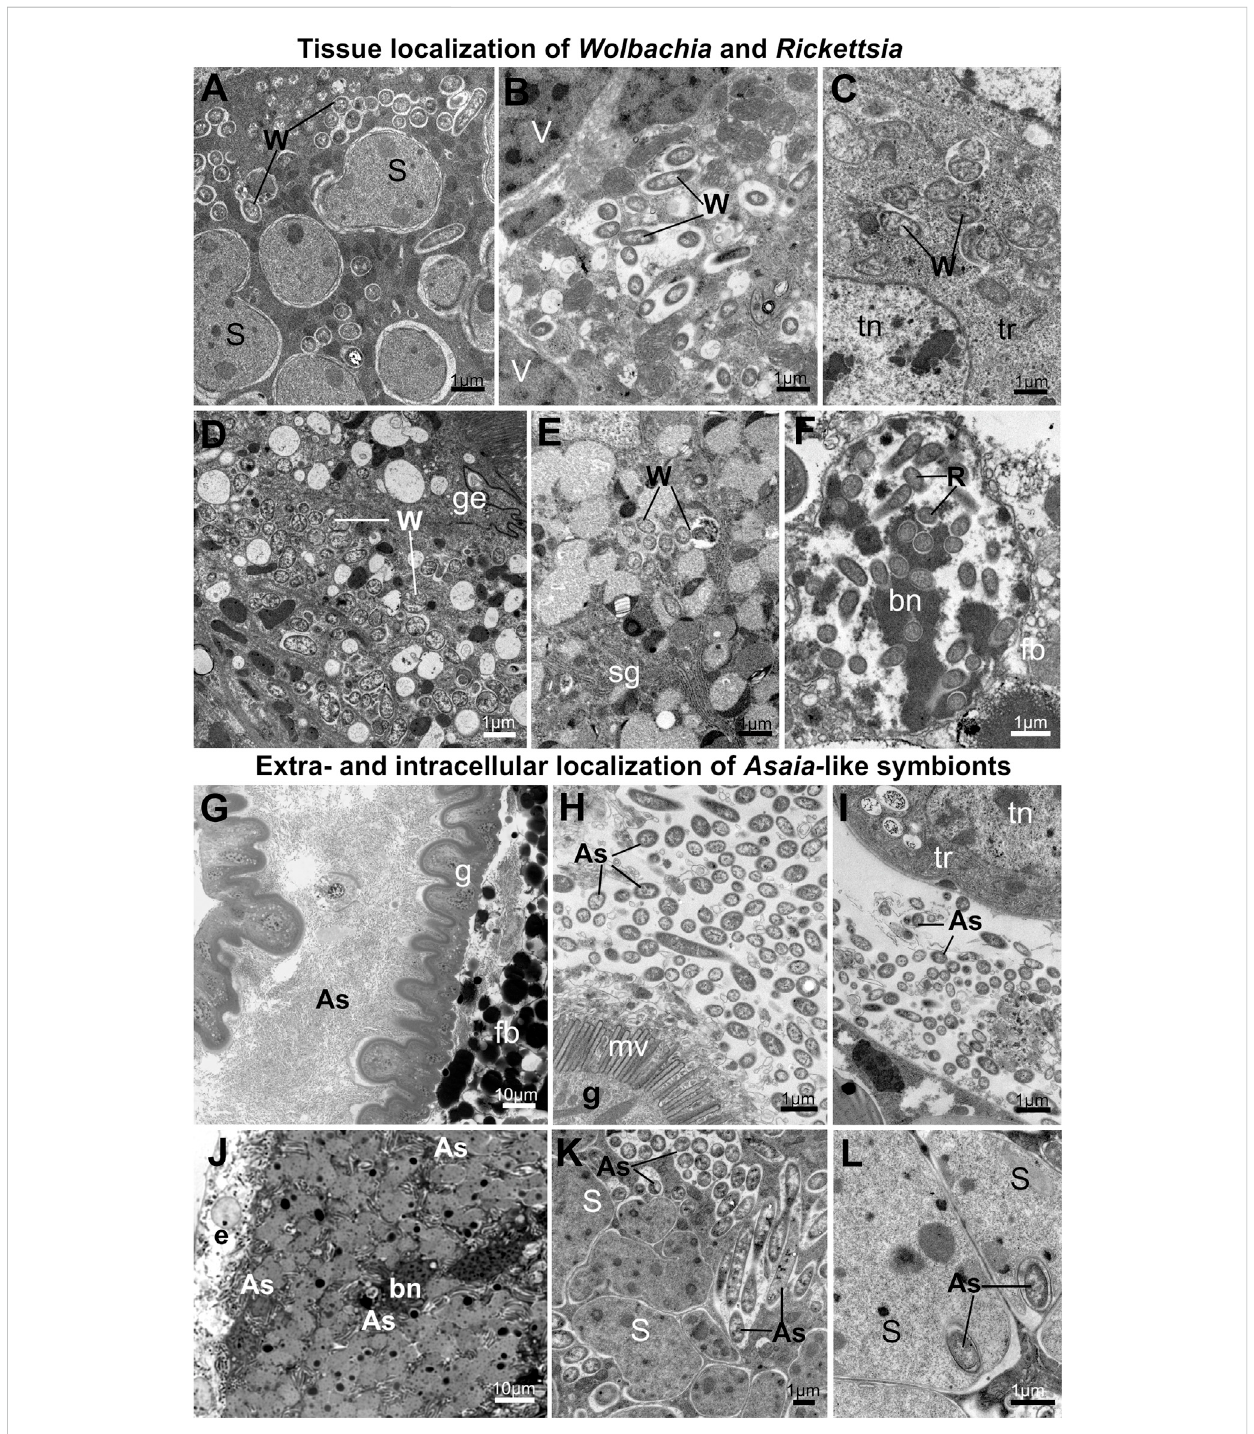
Tissue localization of alphaproteobacterial symbionts in planthoppers. ( A – F) Tissue localization of Wolbachia and Rickettsia symbionts. (A) Wolbachia mixedwith Sulcia cellsinthesharedbacteriome. (B) Wolbachia inthecytoplasmof Vidania bacteriocyte. (C) Wolbachia cellsinthetropharium (part of the ovary). (D) Wolbachia in the gut epithelium (E) Wolbachia in the salivary gland (F) Rickettsia in the nucleus of fat body cell. ( G – L) Extra- and intracellular localization of Asaia -like symbionts. (G,H) Asaia -like symbionts in the gut lumen. (I) Asaia -like cells in the hemolymph. (J) Bacteriome harboring Sulcia and Asaia -likesymbionts (K) Sulcia cellsand Asaia -likesymbiontsinthecytoplasmofsharedbacteriocyte. (L) Asaia -likecellssurrounded by Sulcia projections. For a detailed description of these images, see the main text. (A – F,H,I,K,L) Transmission electron microscope (TEM). (G,J) Light microscope (LM). As - Asaia -like symbiont, bn - bacteriocyte nucleus, e - epithelium, fb - fat body cell, fn - fat body cell nucleus, g- gut, ge - gut epithelium, mv - gut microvilli, R - Rickettsia , S - Sulcia , sg — salivary gland, tn - trophocyte nucleus, tr - tropharium, W - Wolbachia. Insect species: (A) Dictyophara pannonica (Dictyopharidae) (B) Hyalesthes luteipes (Cixiidae) (D) Pentastira rorida (Cixiidae) (E) Ommatidiotus longiceps (Calliscellidae) (F) Orosanga japonica (Ricaniidae) (G,I) Phantia subquadrata (Flatidae) (J – L) Trypetimorpha occidentalis